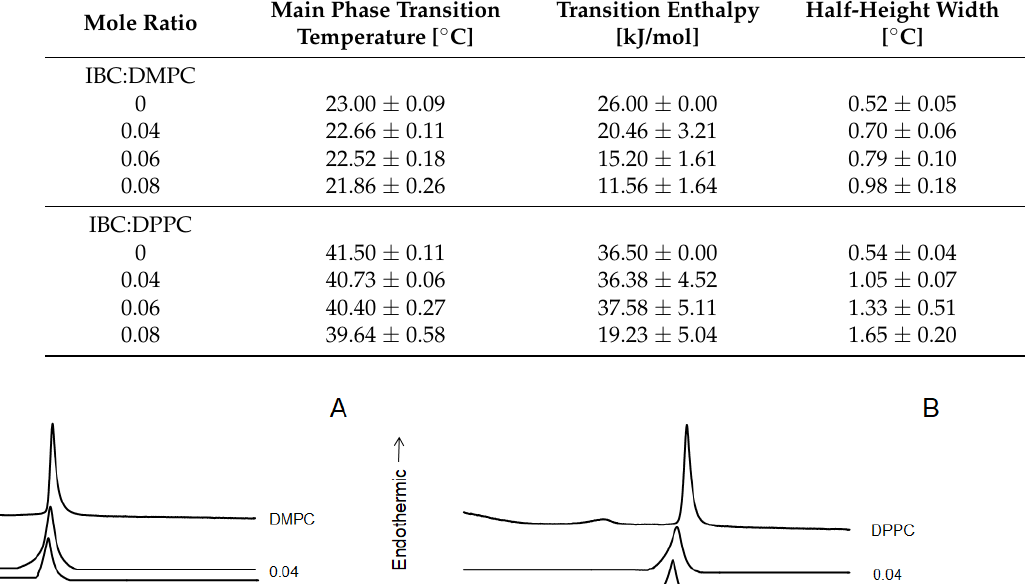
Table 1. Main phospholipid phase transition parameters of phosphatidylcholines and IBC-phosphatidylcholine mixtures. Values are presented as means ± S.D.